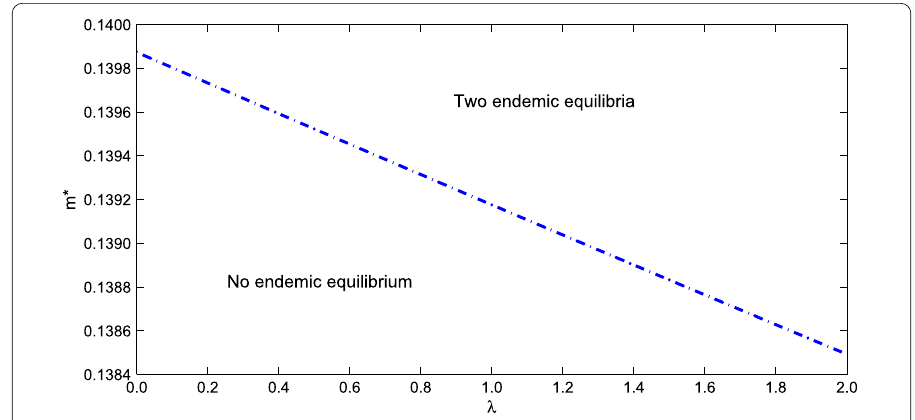
Figure 9 Bifurcation diagram in the plane ( λ , m ∗ ) for parameter values μ = 0.1, β = 0.5, γ = 0.1, h = 60, p = 3, and L = 100. The curve shows the critical value of m below which no endemic equilibrium exists, while above which two endemic equilibria do exist